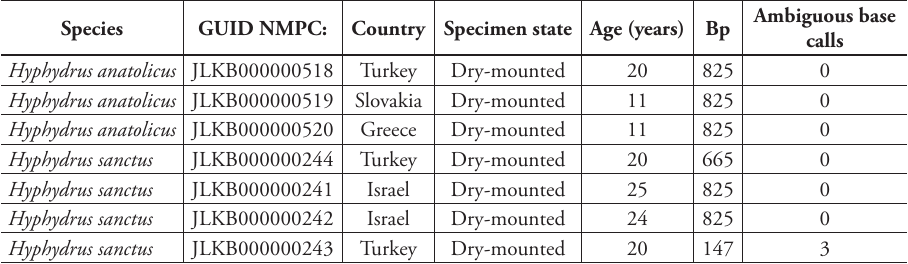
Table 3. Details on the older extracted specimens and the associated DNA data.